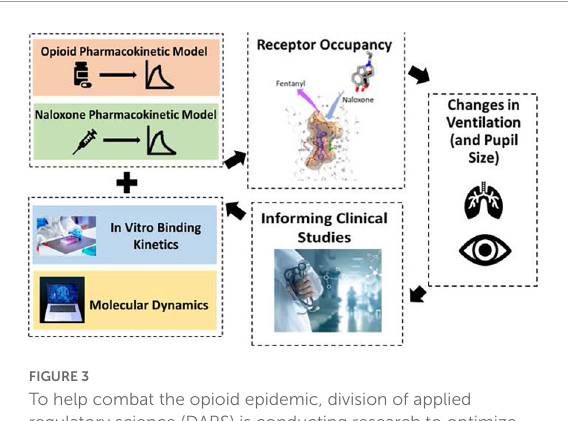
FIGURE3 To help combat the opioid epidemic, division of applied regulatory science (DARS) is conducting research to optimize the use of opioid antagonists and to advance drug development tools to support new opioid antagonists. DARS is using a variety of methods including molecular dynamics, computational modeling, and clinical studies.